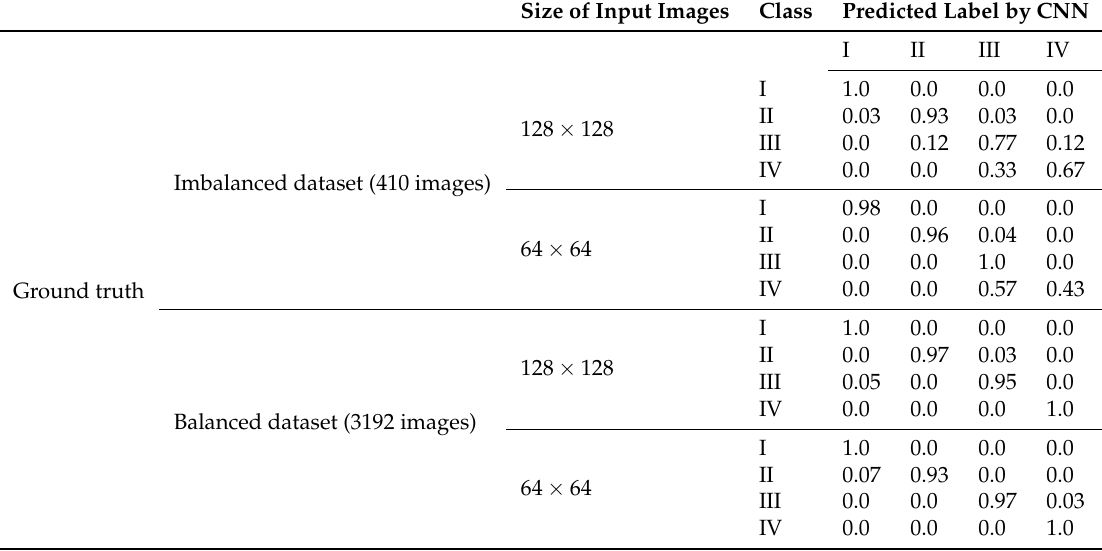
Table 7. Confusion matrix of breast density by CNN-based classification